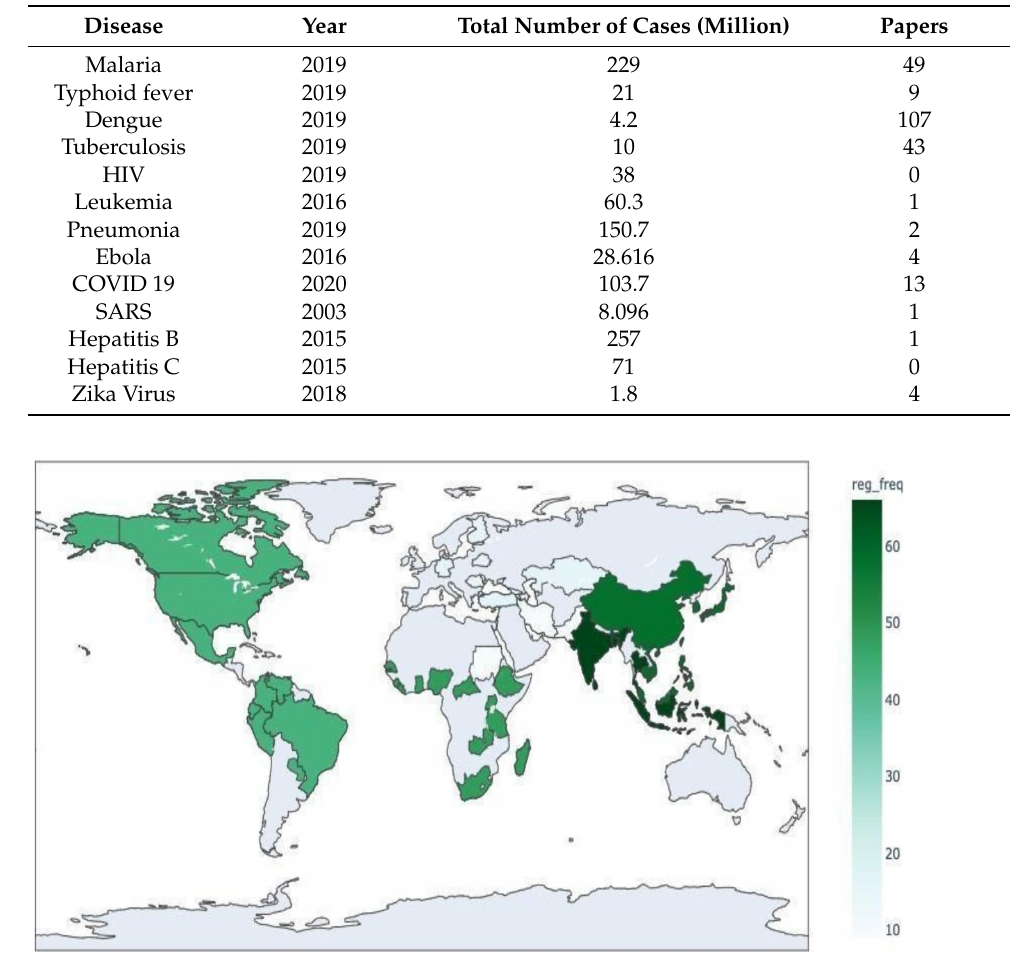
Figure 8. WHO Regions